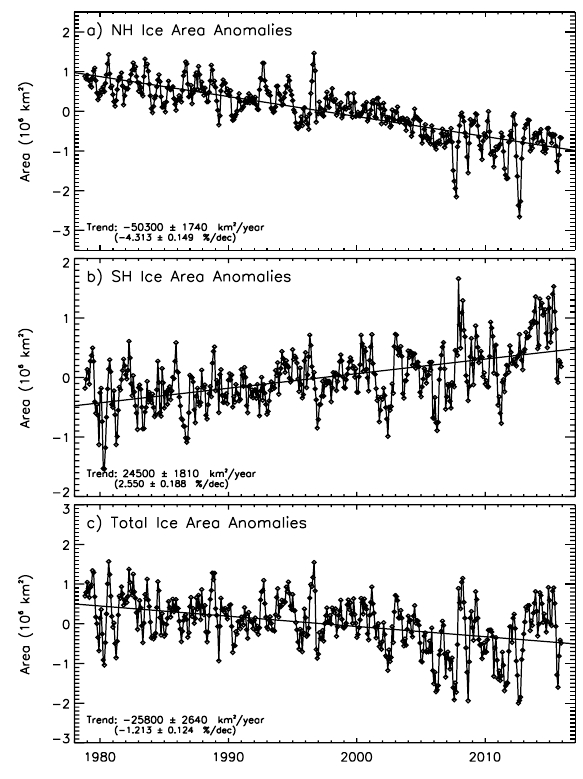
Figure 8. Monthly anomaly of the sea ice area in (a) the Arctic; (b) the Antarctic; and (c) both hemispheres and linear regression line that provides results of trend